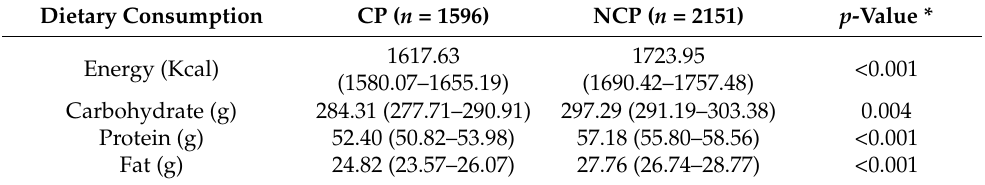
Table 3. Dietary macronutrient consumption by chewing problems in elderly Koreans.